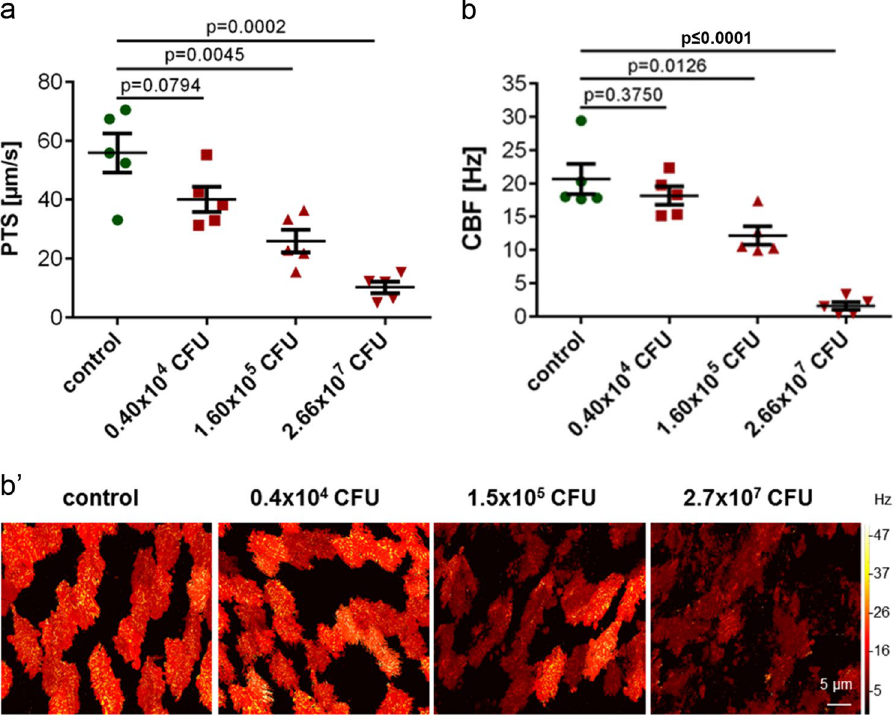
Figure 8. Altered baseline PTS and CBF of tracheal rings cultured in vitro for 4 h with B. pseudohinzii (strain 3227). Baseline PTS ( a ) and baseline CBF ( b ) of tracheal explants incubated with 1.60 × 10 5 and 2.66 × 10 7 CFU (red) are significantly decreased compared to the corresponding control without bacteria (green); n = 5 in each group; (mean ± SEM; Student’s unpaired t-test). The microscopic images in b’ show the mucosal surface with false colour coding of CBF of single ciliated cells; brighter colours represent higher CBF. Decrease in CBF with increasing B. pseudohinzii numbers is a general feature of the majority of ciliated cells and is not restricted to single ciliated